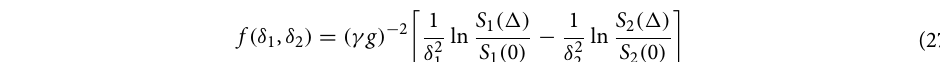
Figure 5. Model’s discriminative power. Panel ( a ) behavior of the f (δ 1 , δ 2 ) Eq. (27) as a function of (cid:31) , obtained from synthetic DW-NMR signals of BM and SS at different δ , D T/m. We used a Gamma distribution as PDF with θ same quantity as in panel ( a ), obtained from synthetic DW-NMR signals of FBM and CTRW with α 9 m 2 s α and the same g as in panel ( a ) . The deviation from the Gaussian stationary signal is well 2 10 D α − − = ×